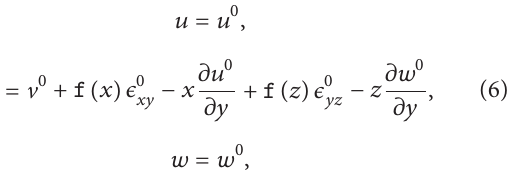
to EBBM, the deformed cross-section remains plane and orthogonal to the beam